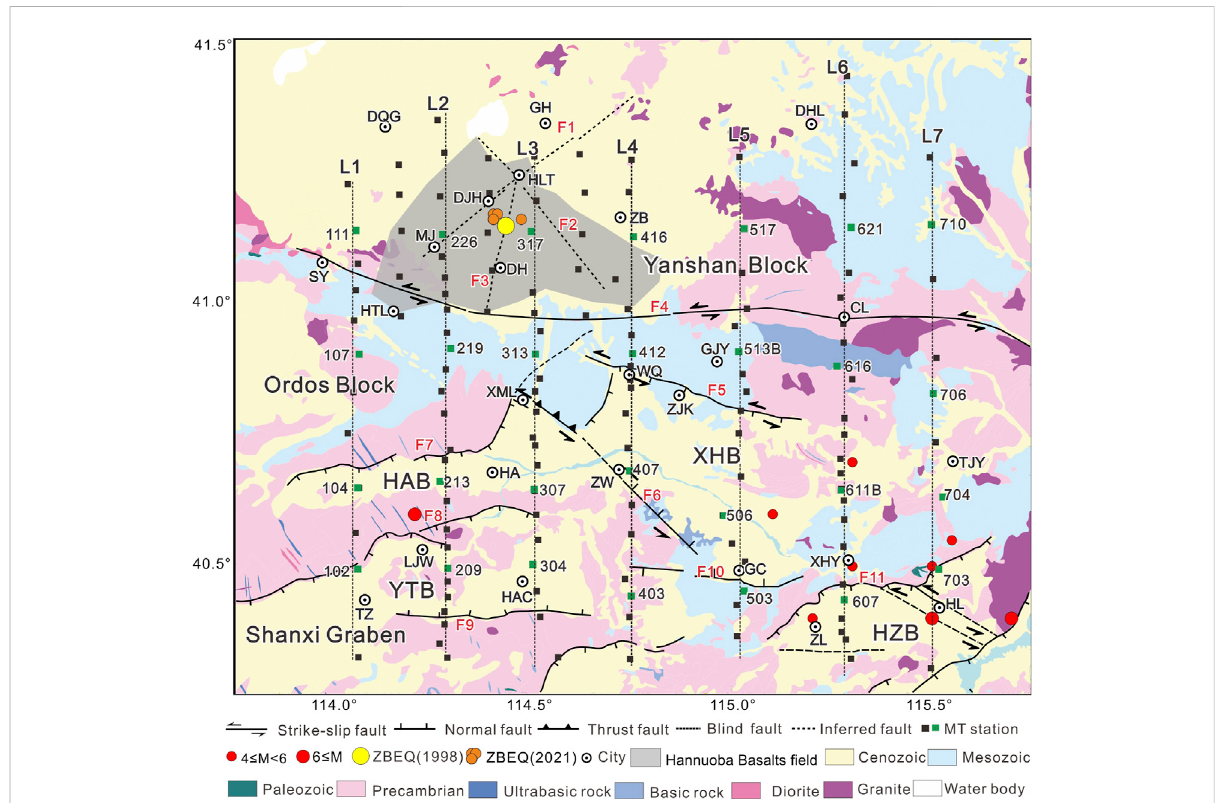
FIGURE 2 Geological setting [modi fi ed from Peng et al. (2017), Zhou (2011); Luo et al. (2021)] and MT stations in studied region. Black Squares denote MT stations; Green square denote typical MT stations in Figure 2; Abbreviations are: HAB, Huaian basin; YTB, Yanggao-Tianzhen basin; XHB, Xuanhua basin; HZB, Huaizhuo basin; F1, Daman-Qianheishatu fault; F2, Miaodongying-Dayingtan fault; F3, Dahezhen-Hailiutu fault; F4, Shangyi-Chicheng fault;F5,Zhangjiakou fault;F6,Ximalin-shuiquanfault;F7,NorthernmarginfaultoftheHuaianbasin;F8,NorthernmarginfaultoftheYanggao- Tianzhen basin; F9, Southern margin fault of the Huaian basin; F10, Southern margin fault of the Xuanhua basin; F11, Northern margin fault of the Huaizhuo basin; DQG, Daqinggou; GH, Gonghui; DHL, Dahulun; HLT, Hailiutu; DJH, Danjinghe; MJ, Manjing; DH, Dahe; SY, Shangyi; CL, Chongli; HTL, Hongtuliang; GJY, Gaojiaying; WQ, Wanquan; XML, Ximalin; ZJK, Zhangjiakou; HA, Huaian; ZW, Zuowei; TJY, Tianjiayao; LJW, LuJiawan; HAC, Huaiancheng; GC, Guocun; XHY, Xiahuayuan; TZ, Tianzhen; ZL, Zhuolu; HL,